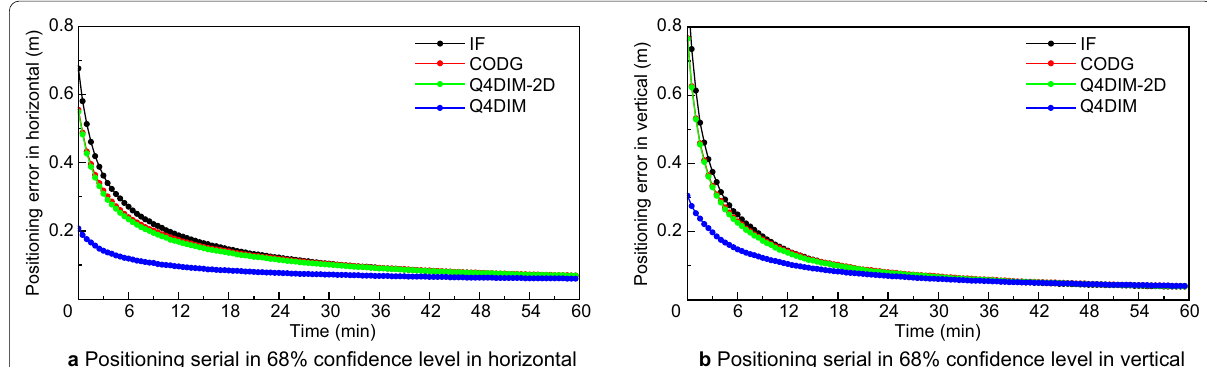
Fig. 13 Double frequency PPP convergence serial for DOY 001–030, 2020, respectively. While for different ionospheric delay processing mode with IF, CODG, Q4DIM‑2D and Q4DIM, the results are denoted in black, red, green, and blue, respectively